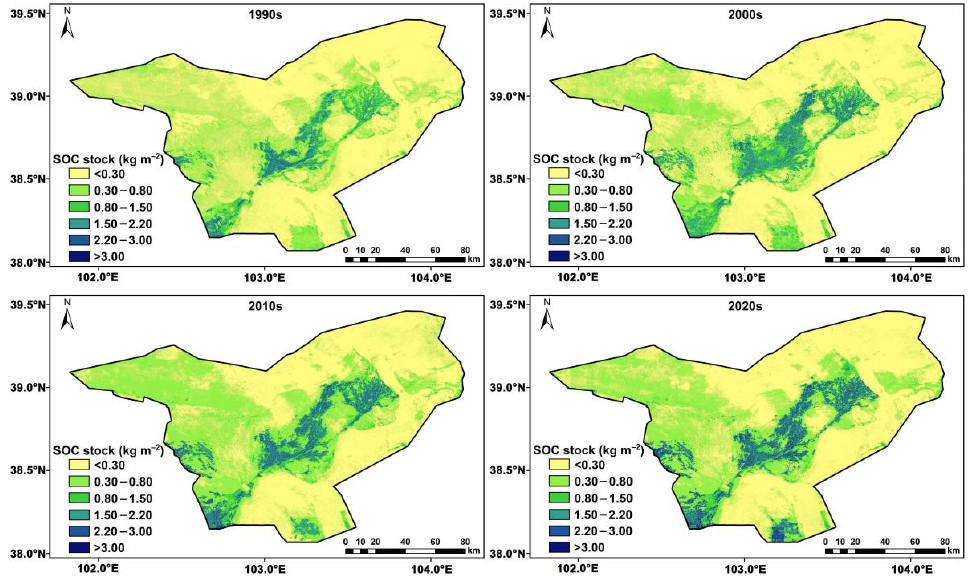
Figure 7. Spatial patterns of SOC stock at 0–20 cm estimated based on 30 runs of the XGBoost models for the 1990s, 2000s, 2010s, and 2020s. Note: SOC stock was mapped at a resolution of 30 m.